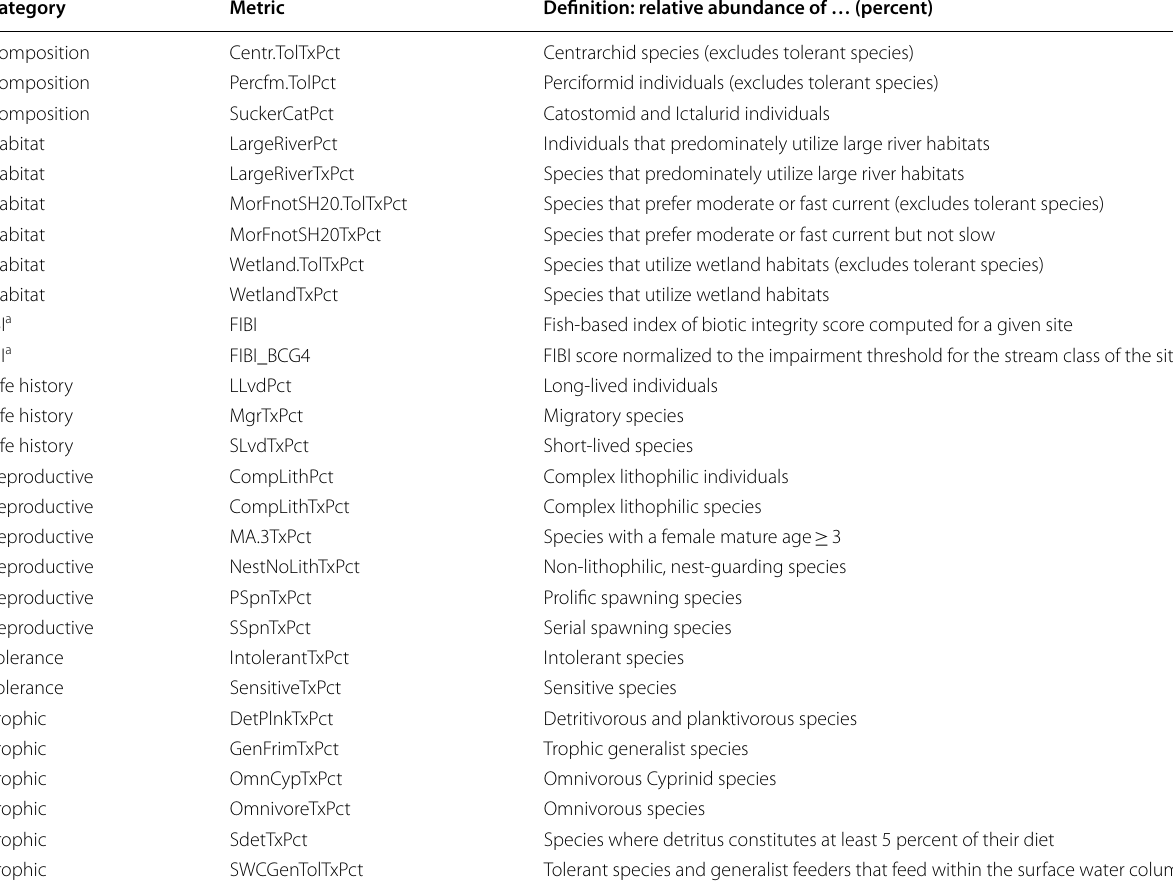
a IBI metric scores are computed using multiple metrics from other categories and are not defined by relative